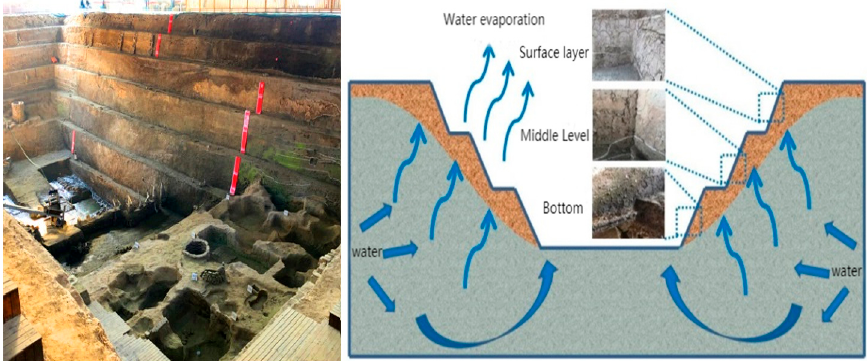
Figure 1. Schematic diagram of working conditions of the Zhouqiao site under dry shrinkage conditions.